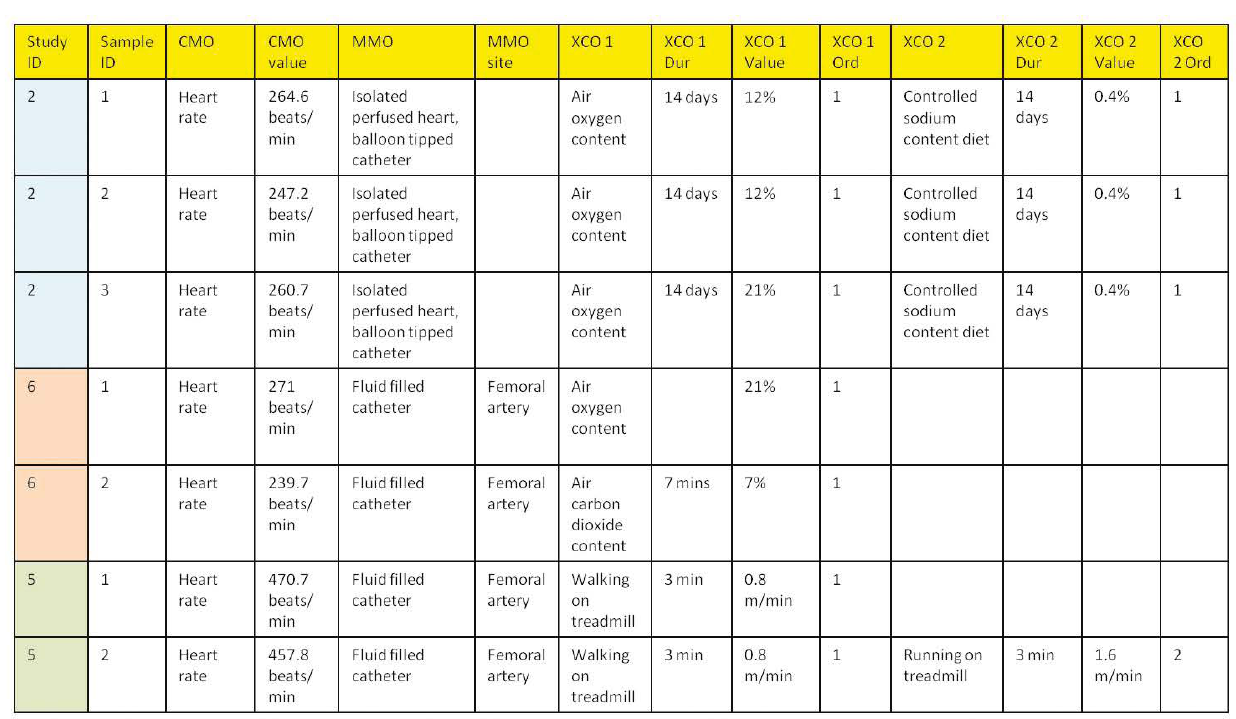
FIGURE 7 | Example of phenotype measurement data from multiple studies mapped to the three ontologies for clinical measurement, measurement method, and experimental